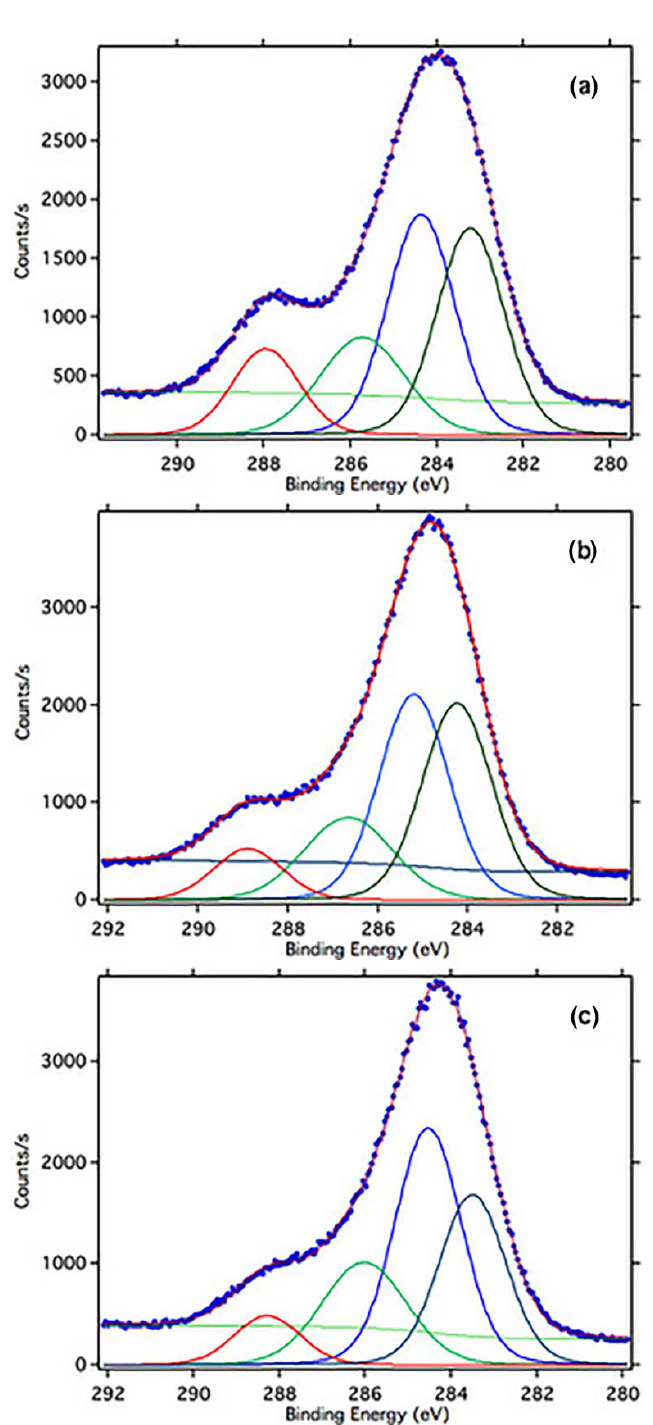
Figure 7. High ‐ resolution C1s peaks of ( a ) untreated PBS, ( b ) O 2 ‐ plasma ‐ treated for 30 s, and ( c ) O 2 ‐ plasma ‐ treated for 30 s and Ar post ‐ crosslinking for 120